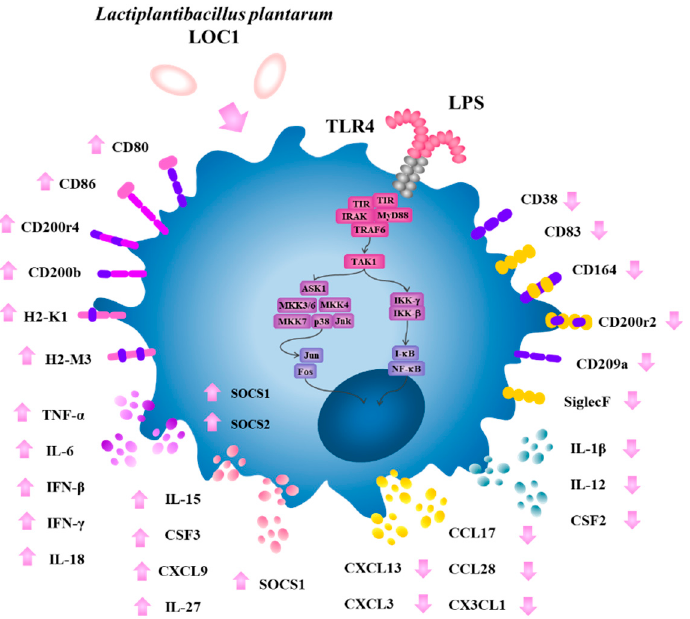
Figure 12. Schematic representation of the immune factor expressions differentially by Lactiplantibacillus plantarum LOC1 in murine RAW macrophages stimulated with the Toll-like receptor 4 (TLR4) agonist lipopolysaccharide (LPS). Up- and down-regulation of immune genes with respect to LPS-treated control macrophages are shown with arrows.